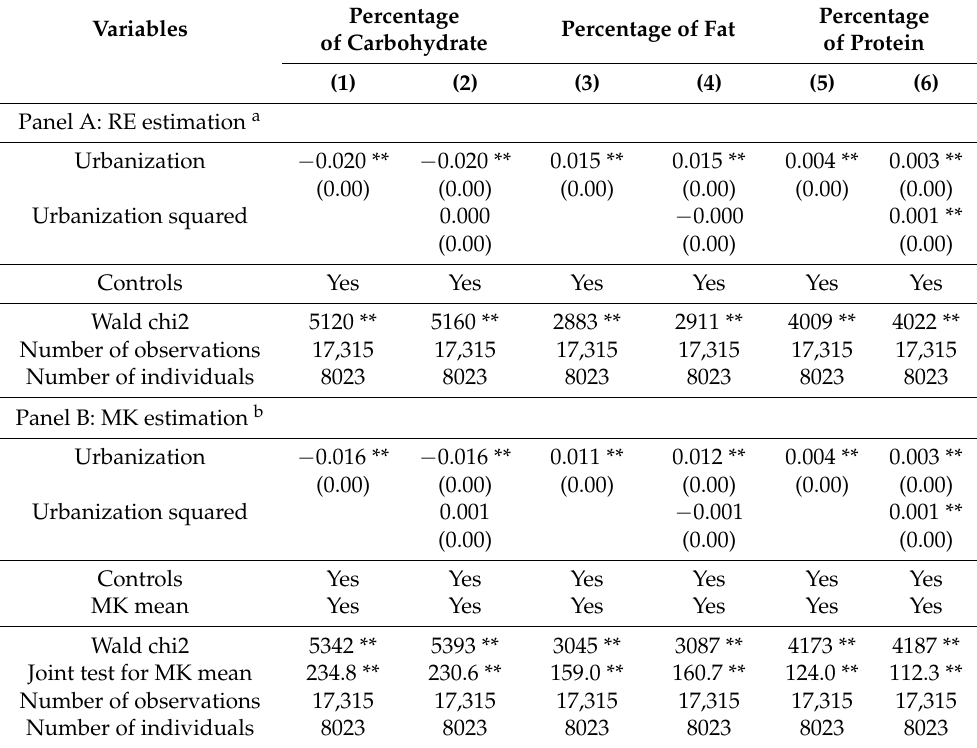
Table 4. The effect of urbanization on the percentage contributions of the